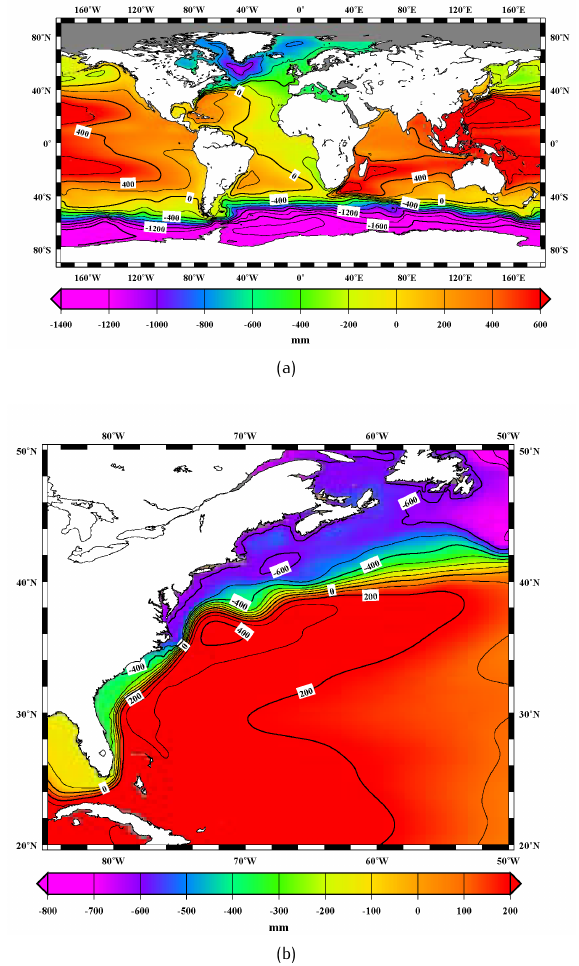
Figure 1. (a) The global Mean Dynamic Topography (MDT) for the period 1993-2002 from the ‘coarse grid’ Liverpool-MIT ocean model. Contours every 200 mm, (b) the MDT from the ‘fine grid’ version of the same model focussing on the western North Atlantic. Contours every 100